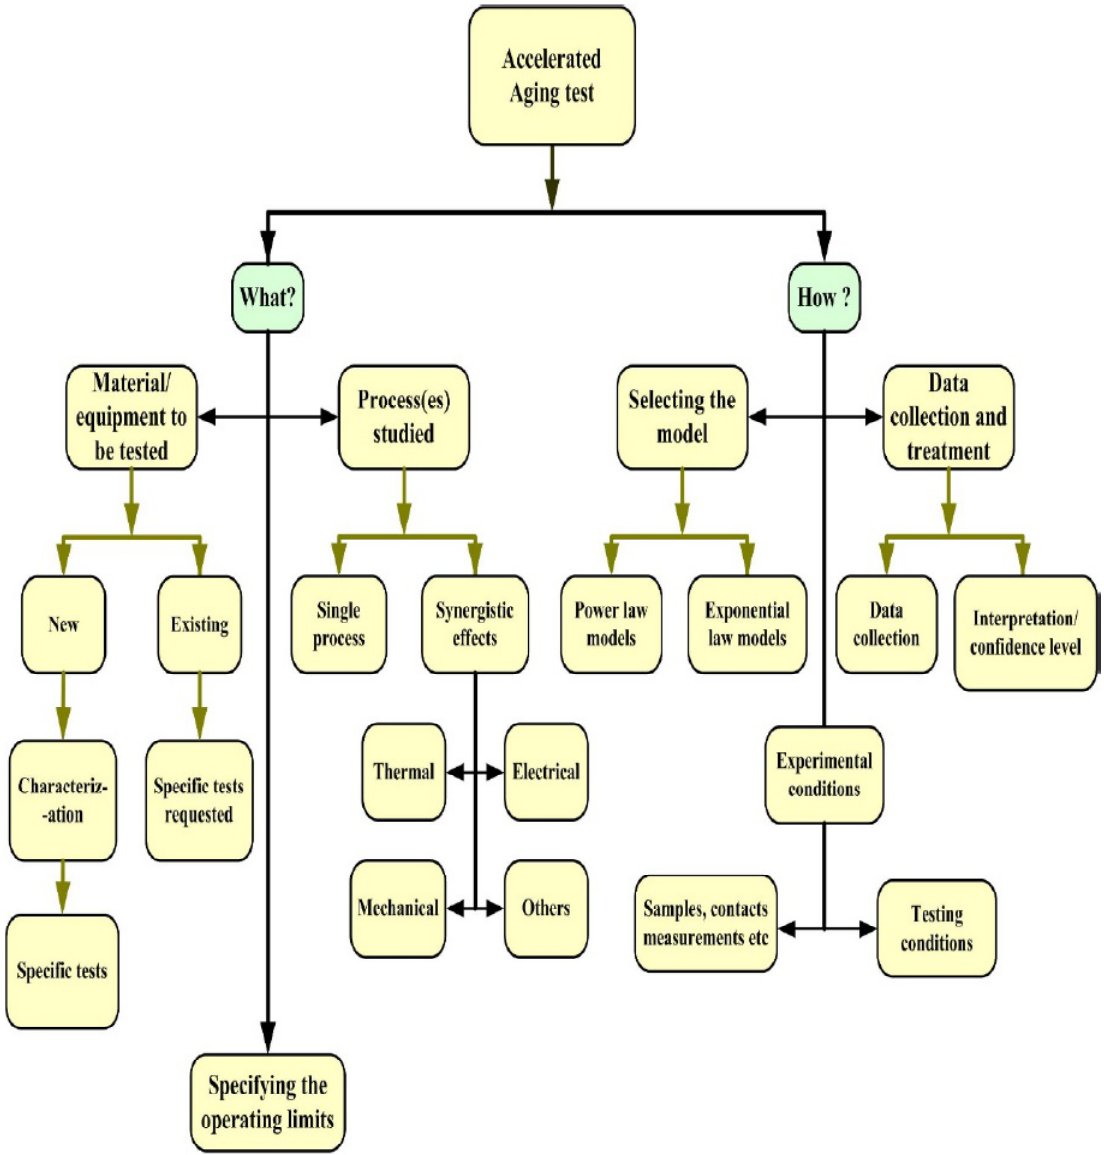
Fig. 18. Different steps of